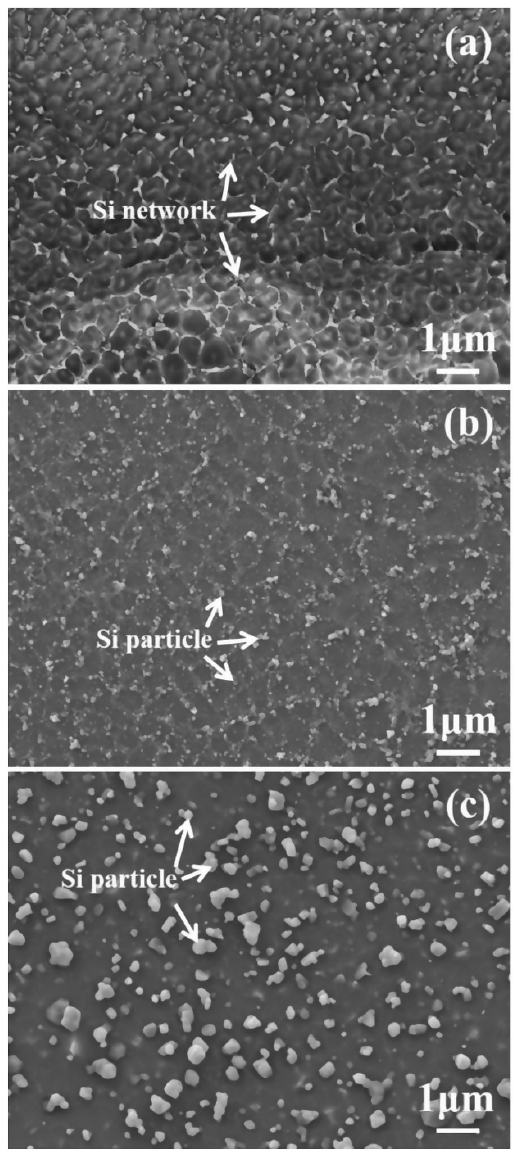
Figure 3. SEM of the SLM AlSi10Mg: ( a ) the untreated; ( b ) heat treated at 300 ◦ C for 2 h; ( c ) heat treated at 400 ◦ C for 2 h [65].